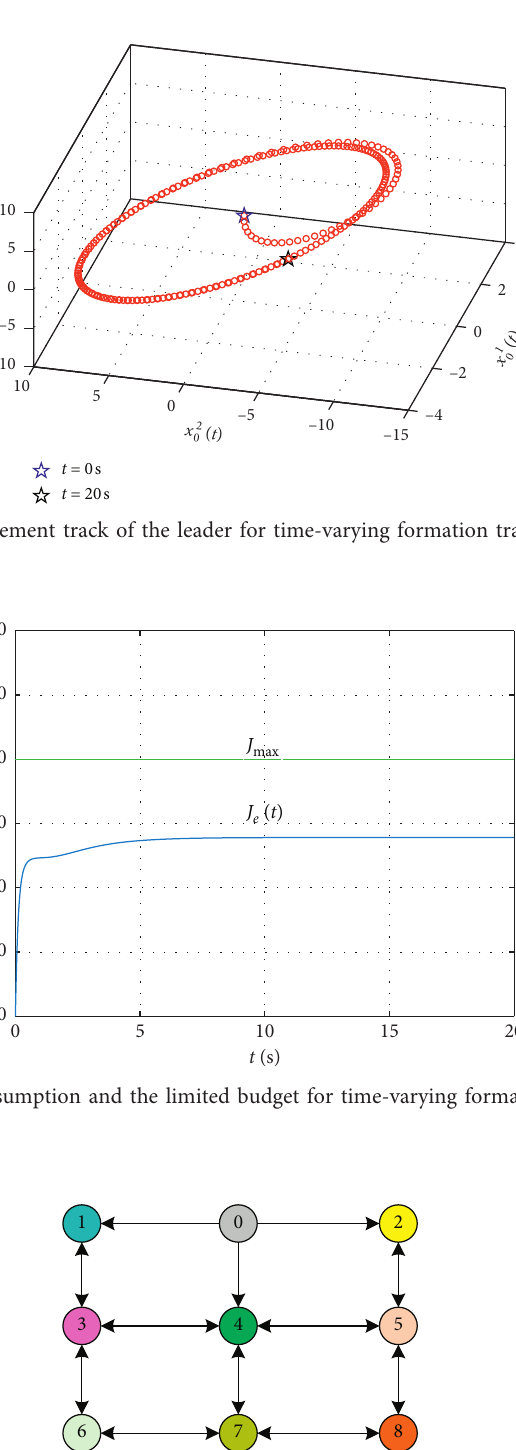
Figure 6: Communication topology for time-invariant formation tracking